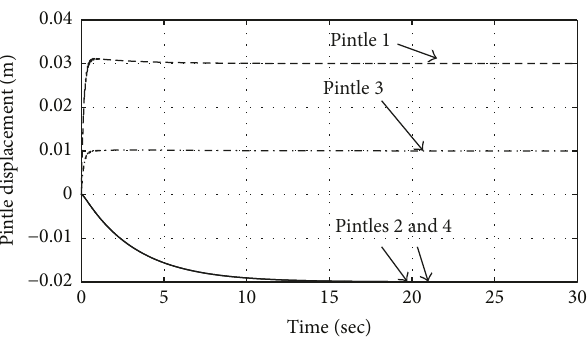
Figure 15: Simulation results, case (4).